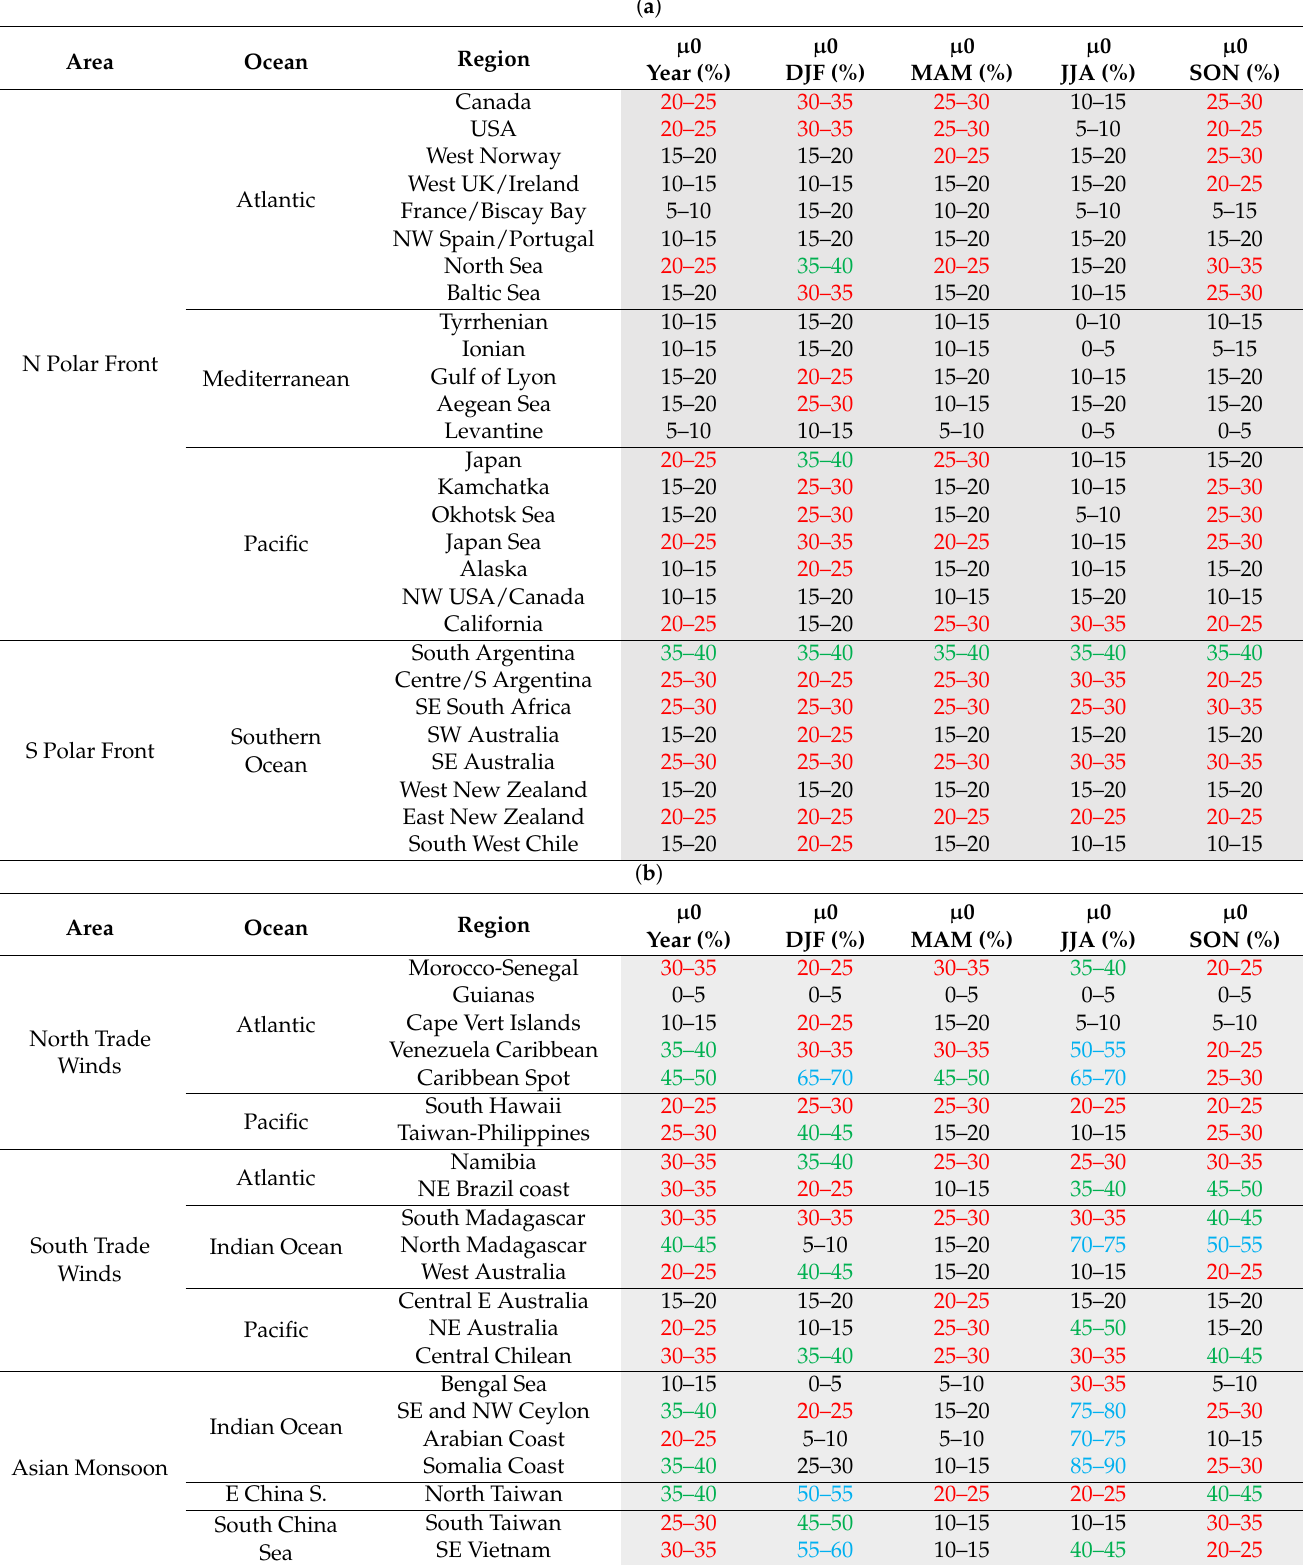
Table 2. ( a ) Ranges of maximum seasonal mean optimum operability near the world coasts in the polar fronts. Color scale: Good (20–35%), very good ( 35–50% ), excellent ( > 50% ). ( b ). Ranges of maximum seasonal mean optimum operability near the